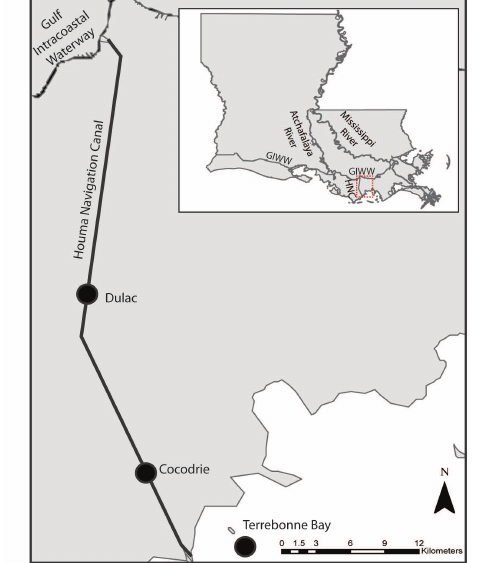
Figure 1. The Houma Navigation Canal (HNC) including the Cocodrie station where hourly velocity and wind time series measurements and tidal cycle hydrographic surveys were conducted. Horizontal salinity gradients were calculated as the difference between salinity at Terrebonne Bay and Dulac. Also shown are the Atchafalaya and Mississippi Rivers and the Gulf Intracoastal Waterway